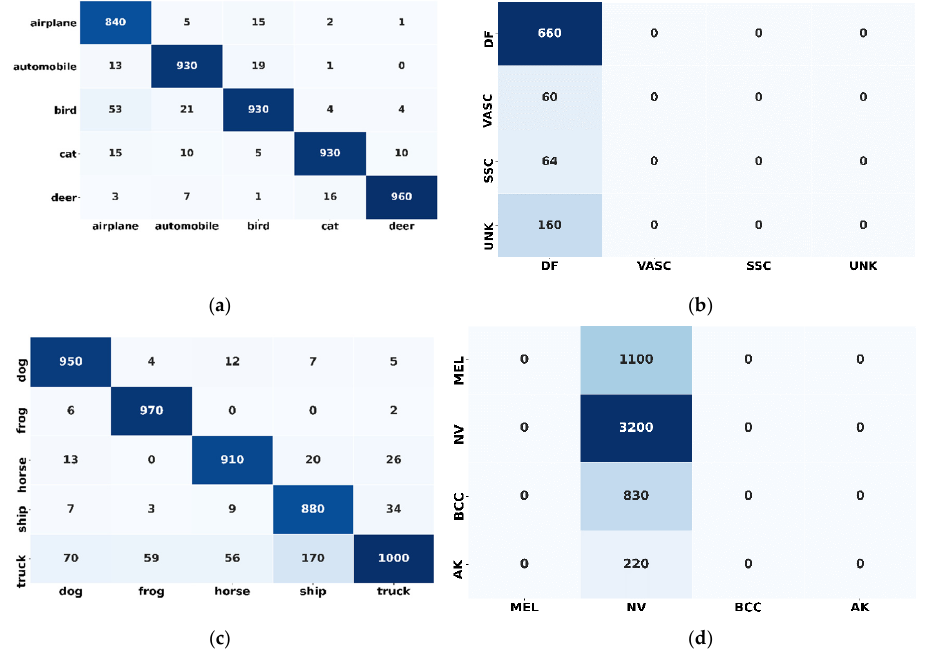
Figure 7. Confusion matrix: ( a ) Confusion matrix of model1_CF10 before novel class arrival; ( b ) Confusion matrix of model2_SD before novel class arrival; ( c ) Confusion matrix of model1_CF10 after novel class arrival; ( d ) Confusion matrix of model2_SD after novel class arrival.